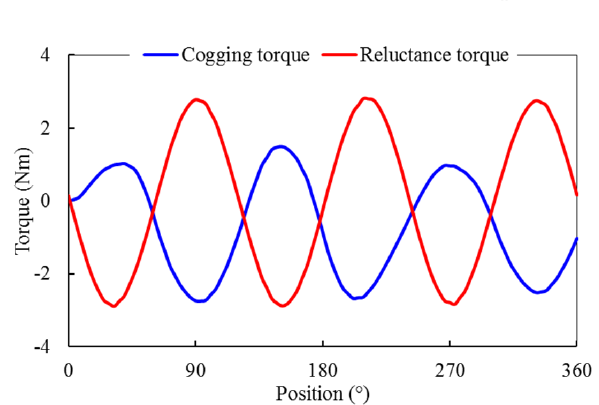
Figure 19. Comparisons of the cogging torque and reluctance torque.